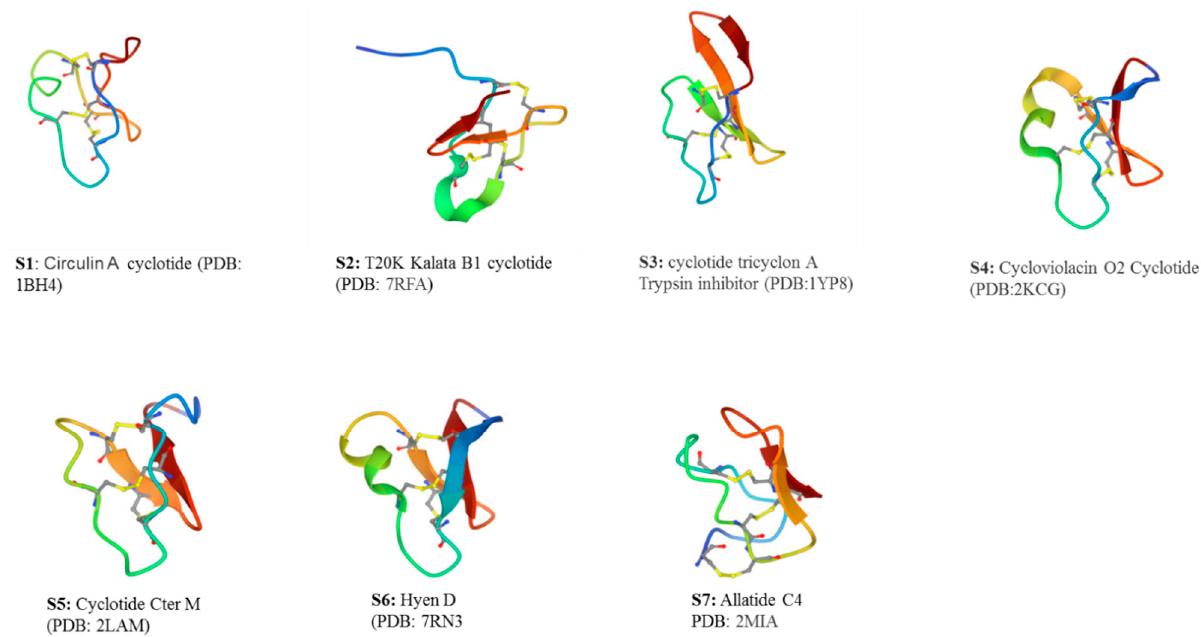
Figure 4. Three dimensional structures of some selected cystine knot cyclotides from botanical sources: ( S1 )—Antimicrobial cyclotide; ( S2 )—In clinical trials for multiple sclerosis; ( S3 )—Antifungal cyclotide; ( S4 )—Antibacterial cyclotide; ( S5 )—Anti-inflammatory cyclotide; ( S6 )—Anticancer cyclotide; ( S7 )—Antidiabetic cyclotide. The circular configuration complements the knotted structural core making knottin-like cyclotides the foremost peptide molecules for application in biotechnology, drug discovery and in agriculture.